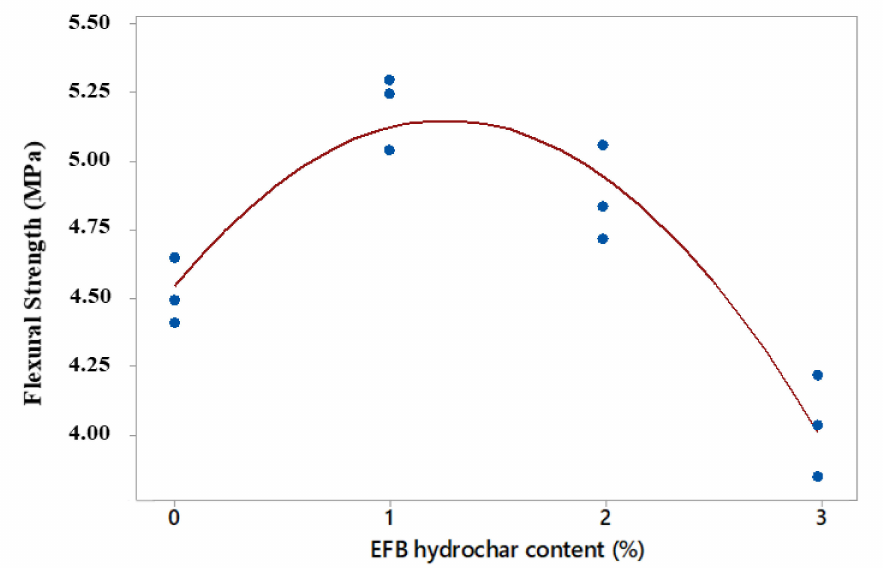
Figure 10. The quadratic model of the relationship between the mortar flexural strength and EFB hydrochar